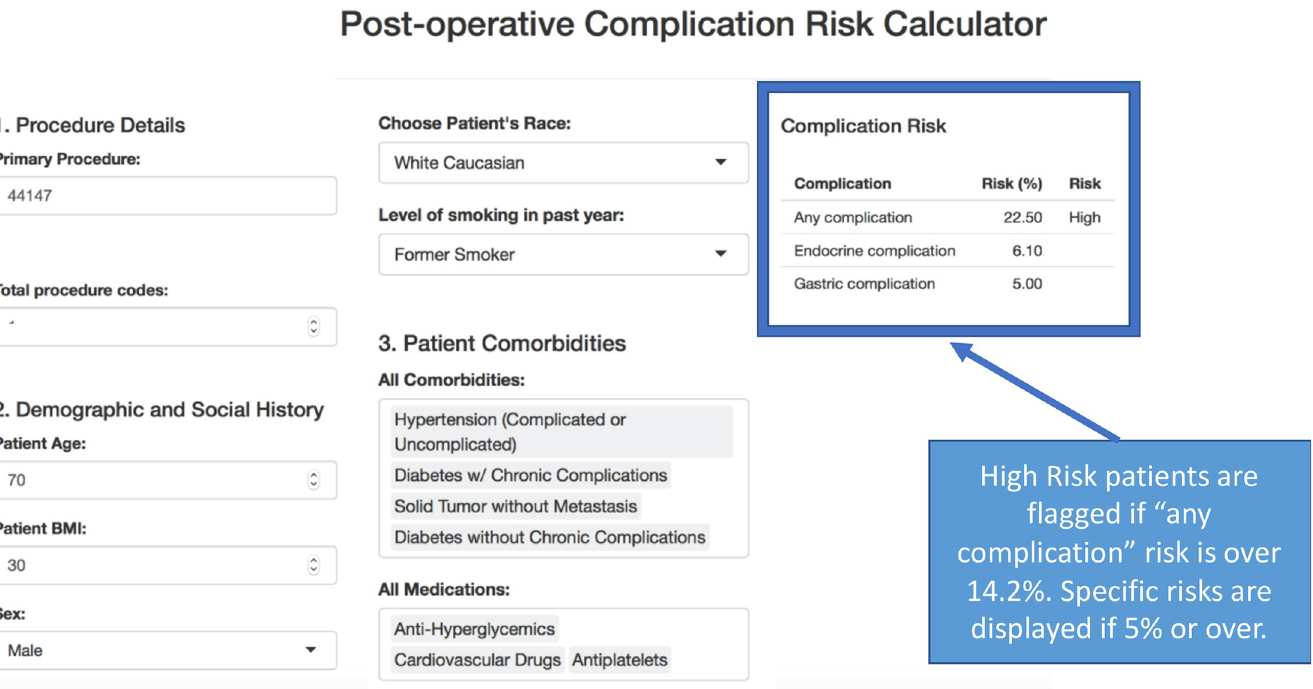
Fig 6. R Shiny application hosting the preoperative risk prediction calculator to use for preoperative patient evaluation in clinic. The calculator includes 9 input fields and calculates a percent risk for each of the 14 postoperative outcomes per patient. The calculator also identifies patients who meet the determined high-risk